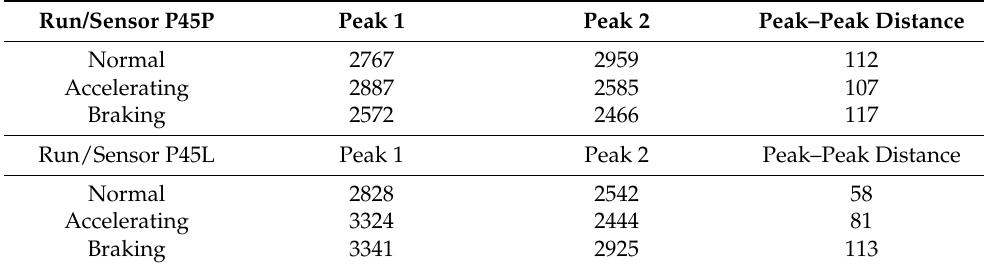
Figure 21. Example signals for the twin wheel from the piezoelectric sensors at constant speed, acceleration, and braking—five-axle vehicle. Table 10. Piezoelectric sensor signal characteristics—amplitude (ADU) and Peak–Peak separation distance (samples) for a twin wheel.